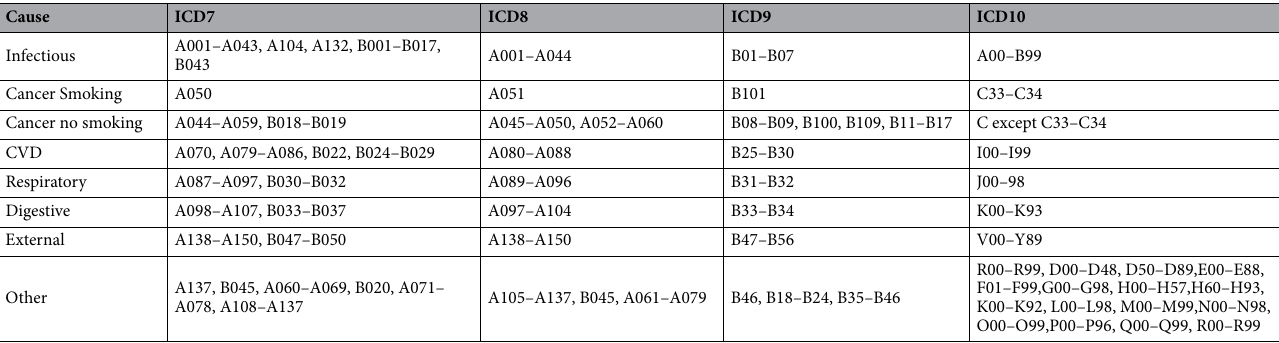
Table 3. ICD codes and our classification into eight major groups. Source: authors’ own elaborations on data from the WHO 33